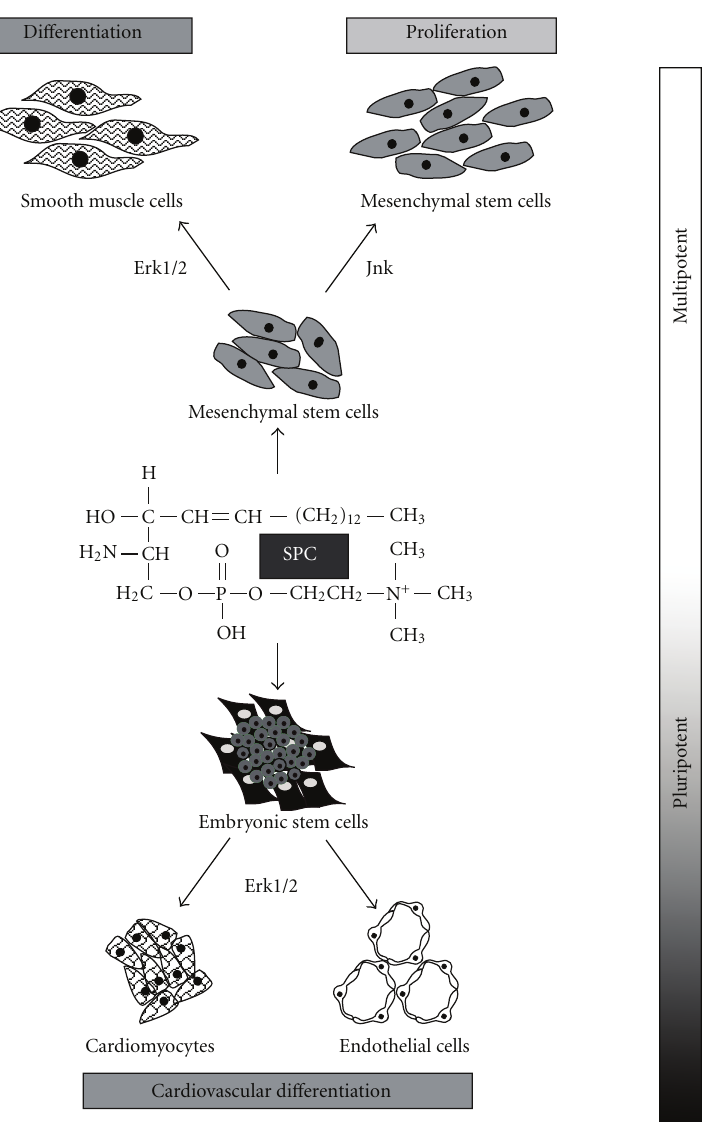
Figure 3: Schematic illustration of SPC-induced di ff erentiation in murine multipotent and pluripotent stem cells. Signaling pathways mediating the respected phenotype are noted next to black